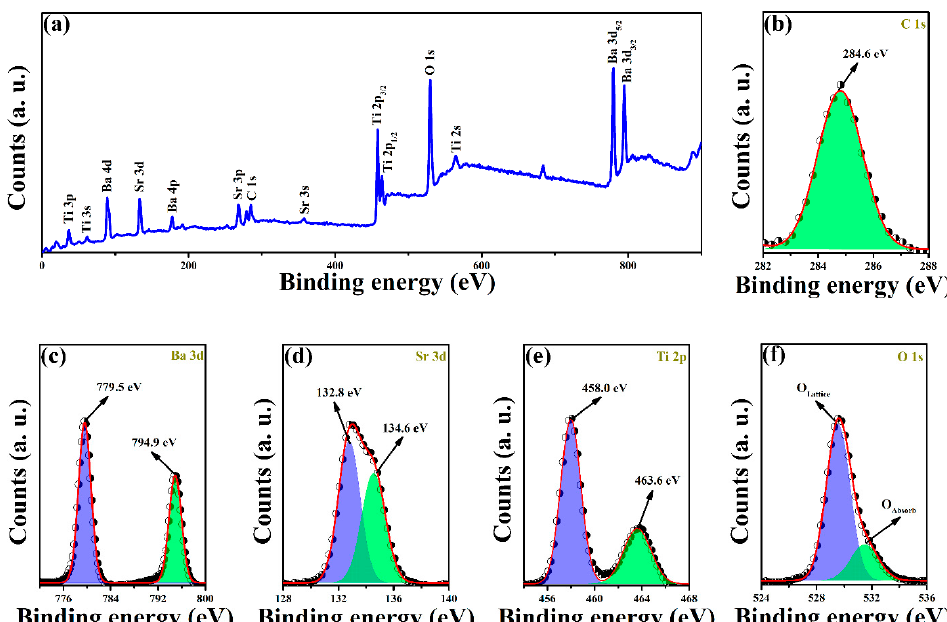
Figure 2. ( a ) Survey scanning of BST films. ( b – f ) High resolution XPS of C 1s, Ba 3d, Sr 3d, Ti 2p, and O 1s.